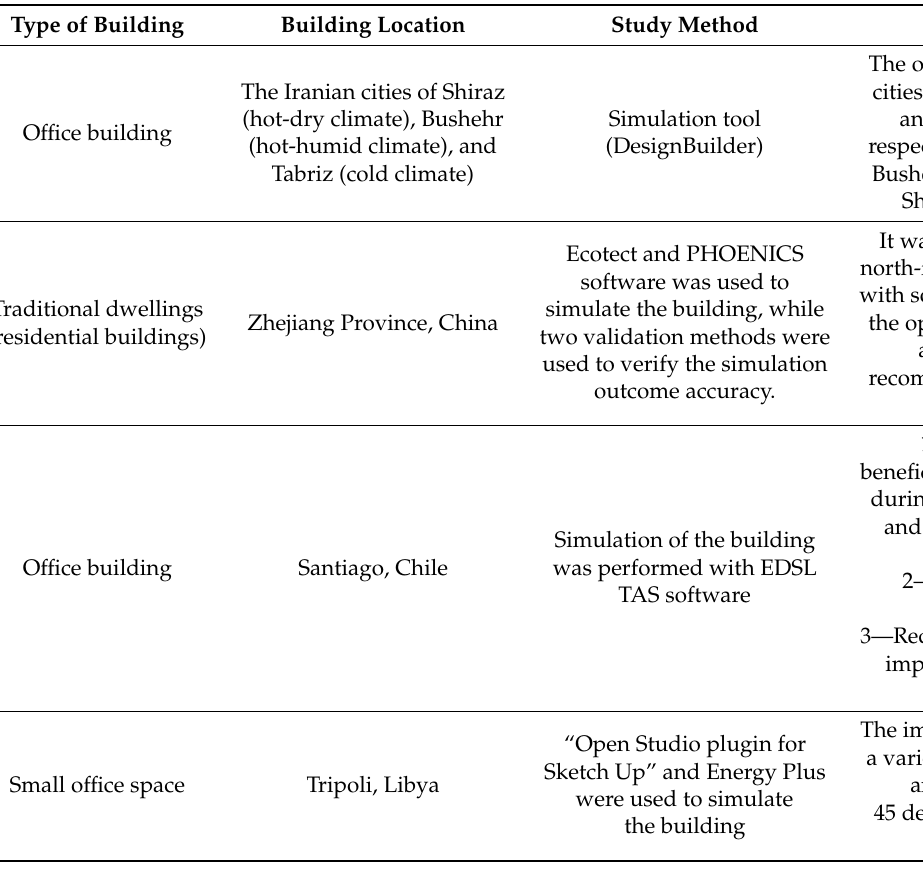
Table 1. Summary of studies on the optimum